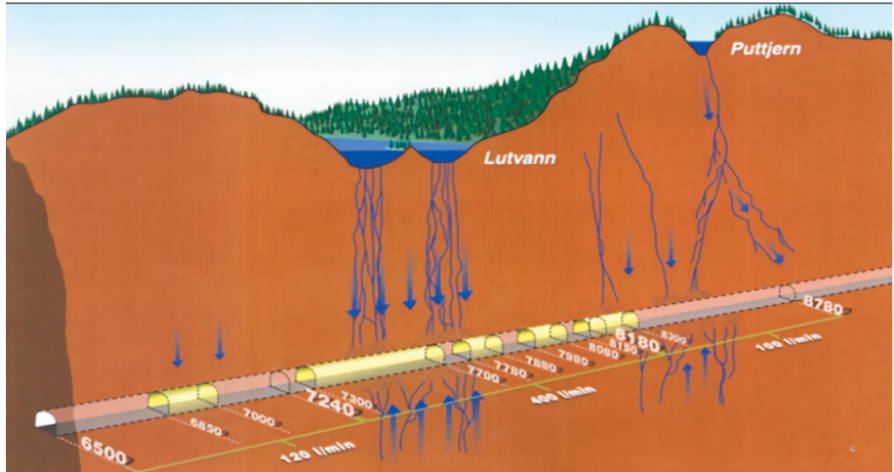
Figure 9. Schematic diagram of the tunneling overview.